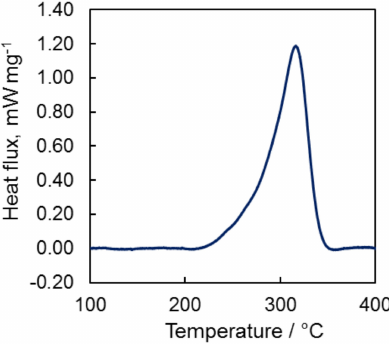
Figure 6. DSC curve for cyclotrotrimerization of compound 7 (heating rate of 10 ◦ C min − 1 , argon